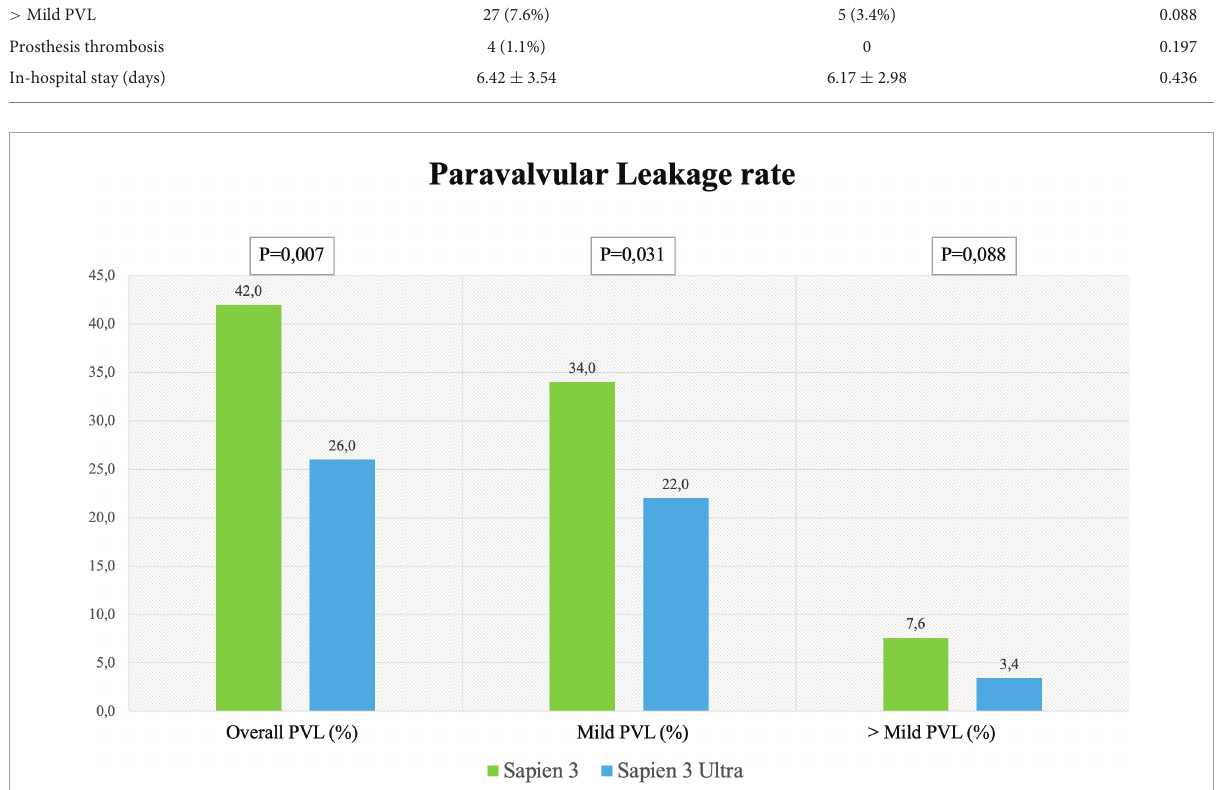
FIGURE6 Paravalvular leakage rate. Rate of overall, mild and more than mild paravalvular leakage rate after SAPIEN 3 or SAPIEN 3 Ultra